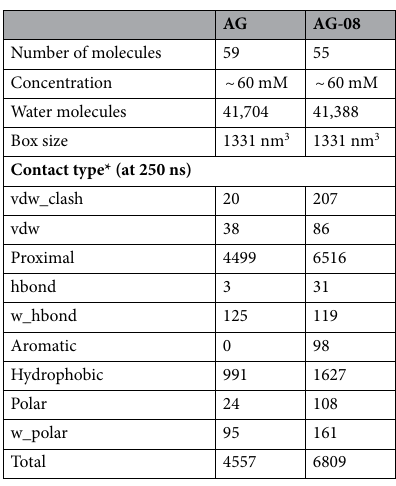
Table 1. Molecular systems used in MD simulations and the number of each contact type observed at 250 ns of simulation